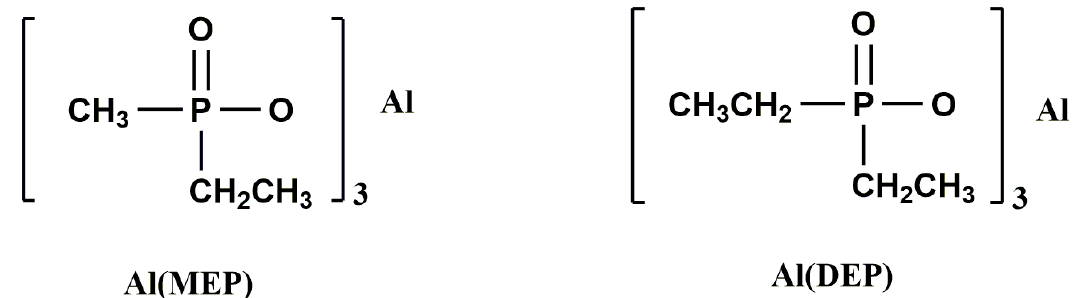
Figure 2. Preparation of polyphosphate flame retardant-epoxy resin (PFR-EP) semi-interpenetrating polymer network (SIPN) composites. Readapted with permission from Ref. [67], Copyright 2014, The Royal Society of Chemistry.